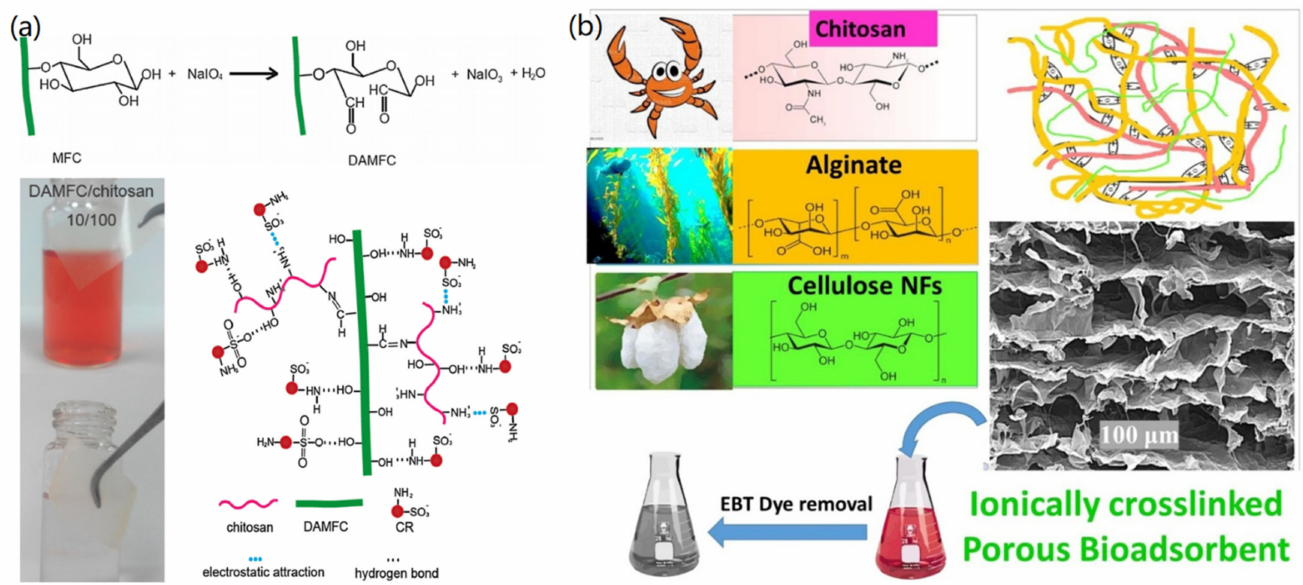
Figure 7. CNF-based functional nanomaterials for the removal of dyes: ( a ) Dialdehyde microfibrillated cellulose/chitosan film for removing Congo red. Reproduced from Ref. [87], Copyright 2018, Elsevier Ltd. ( b ) 3D porous chitosan/alginate/ CNF bioadsorbents for removing Eriochrome black-T (EBT) anionic dye. Reprinted from Ref. [88], Copyright 2021, Elsevier